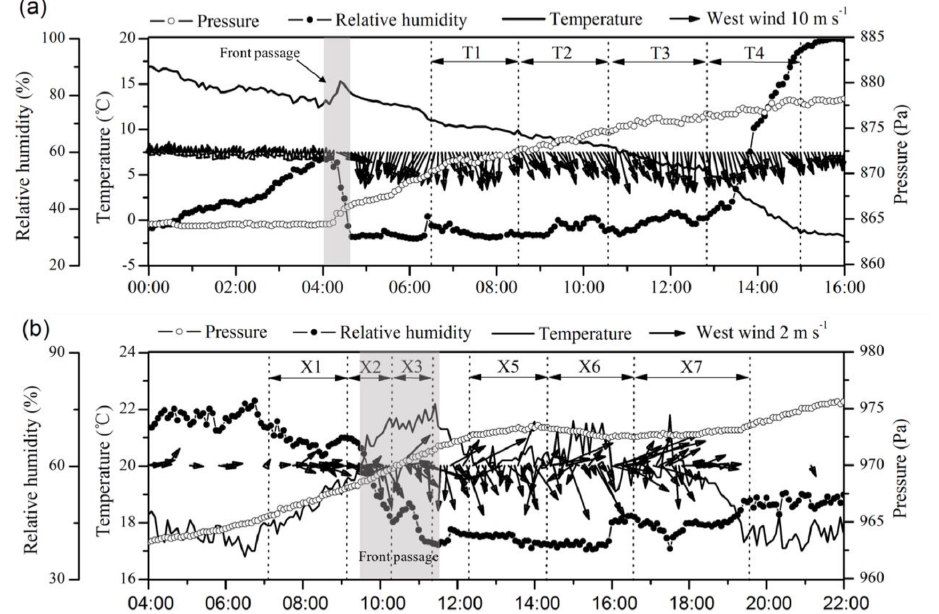
Figure 2. Surface pressure, temperature, relative humidity (RH) and wind during the sampling periods at the desert site ( a : 24 April 2014 04:00–15:00BST) and at the Xi’an site ( b : 1 May 2014 04:00–12:00BST). Also shown are the front passage (shaded bars) and the durations of sample collections (Table